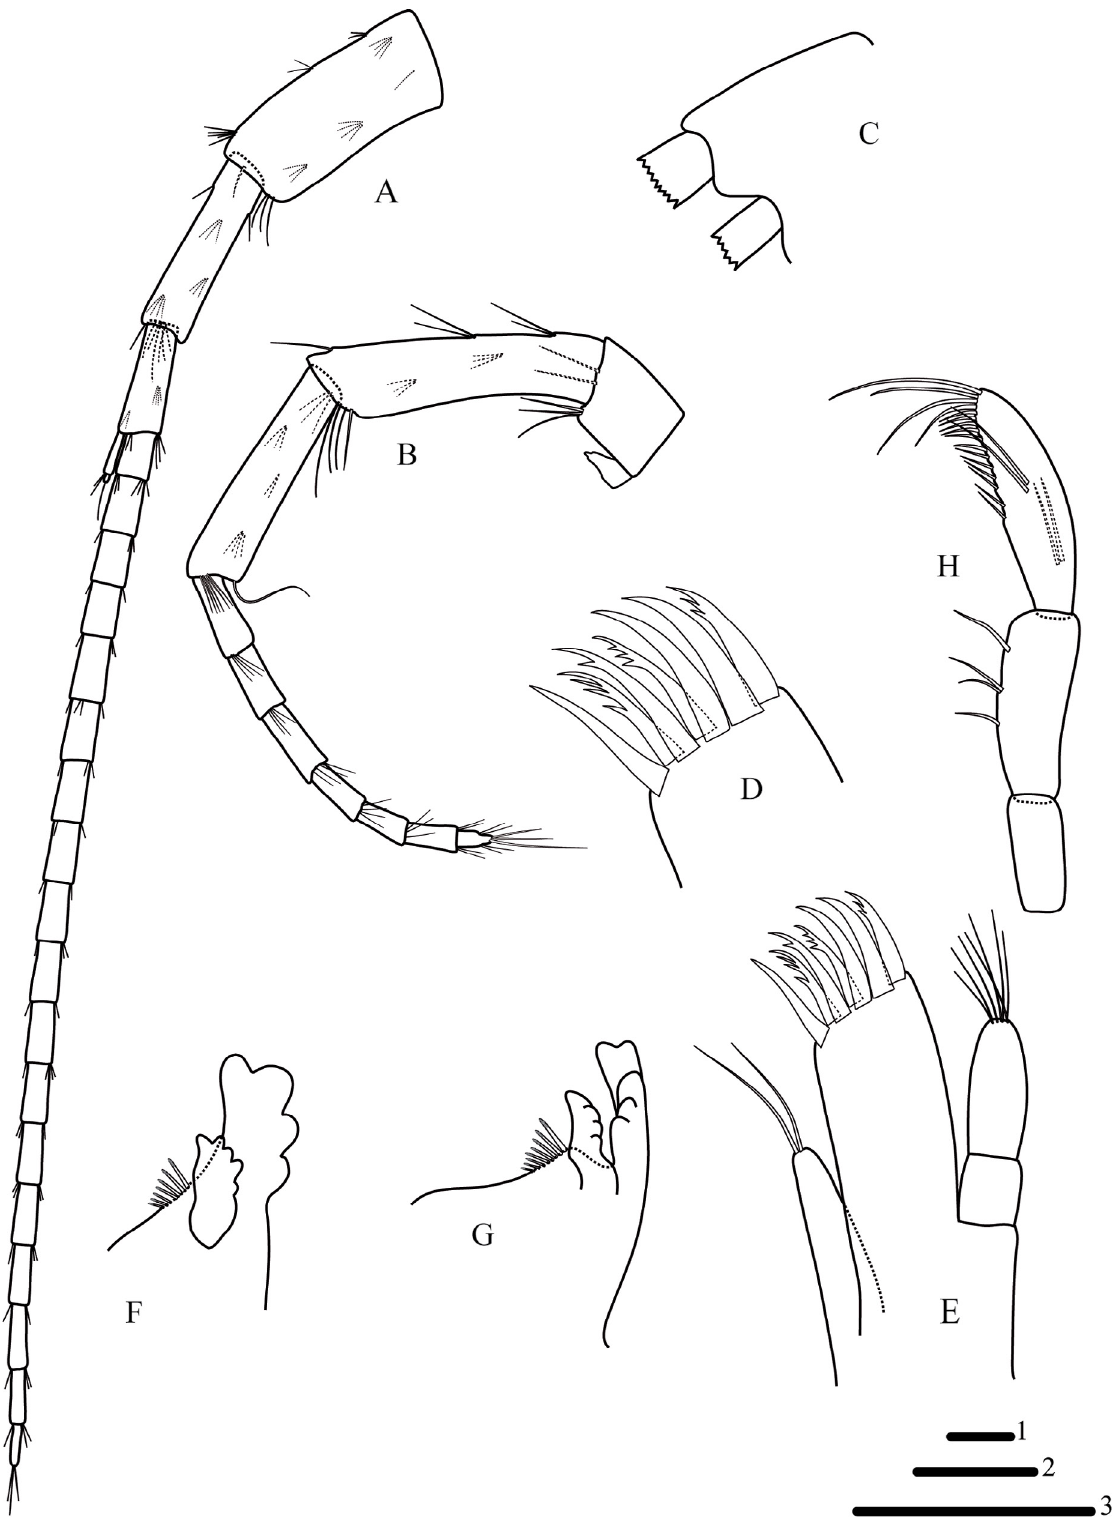
Fig. 3. Niphargus urmiensis sp. nov., holotype, ♂, 8 mm (ZCRU Amph.1071). A . Antenna I. B . Antenna II. C . Head. D–E . Maxilla I. F . Left mandible. G . Right mandible. H . Mandibular palp. Scale bars: 1 = 0.25 mm (F–G); 2 = 0.5 mm (C–E); 3 = 1 mm